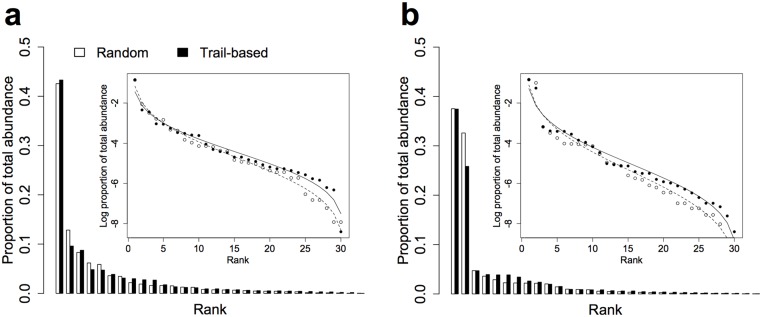
Rank abundance distributions and lognormal model fits (inset plots) for the (a) dry and (b) wet season.A set of 30 species was considered in order to facilitate comparison, with ranks based on RAIs measured at the survey level. Species are ranked from 1 to 30 on the x-axis according to decreasing proportion of total abundance.